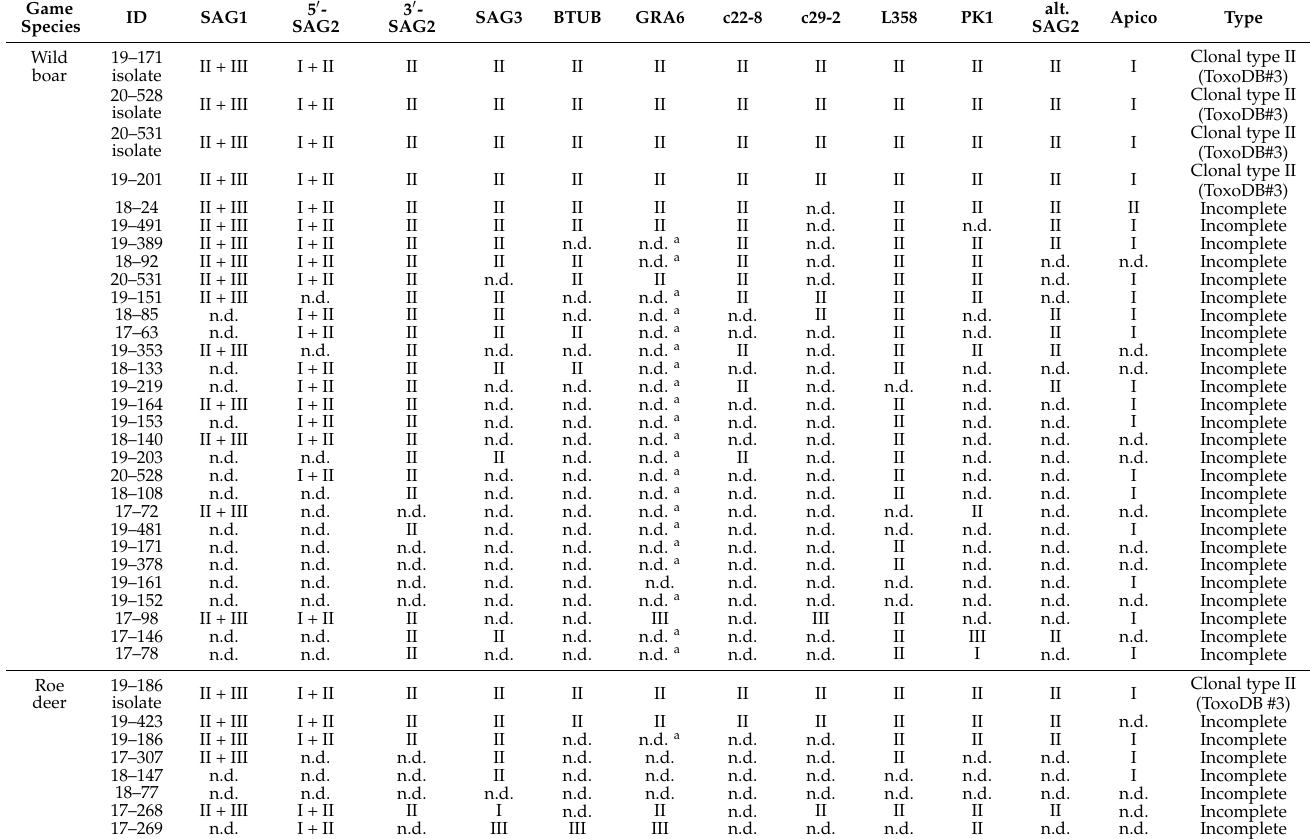
Table 7. Genotyping of Toxoplasma gondii –positive samples by PCR-restriction fragment length polymorphism (PCR-RFLP) in twelve genetic